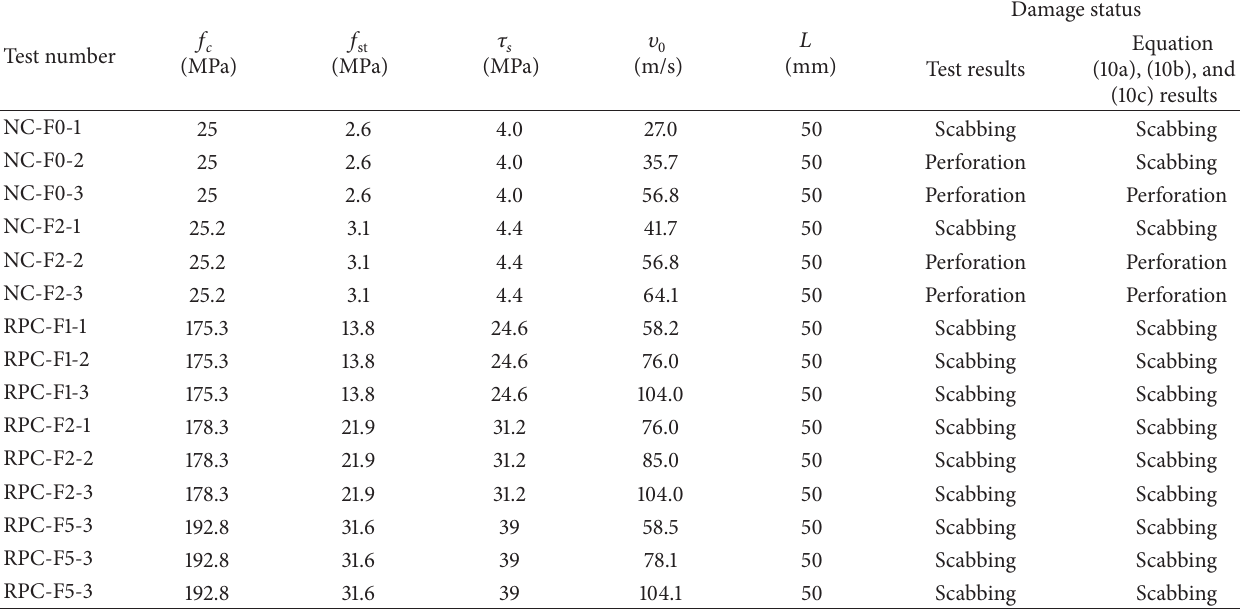
Table 1: Tai’s experimental parameters and the predicted results with (10a), (10b), and